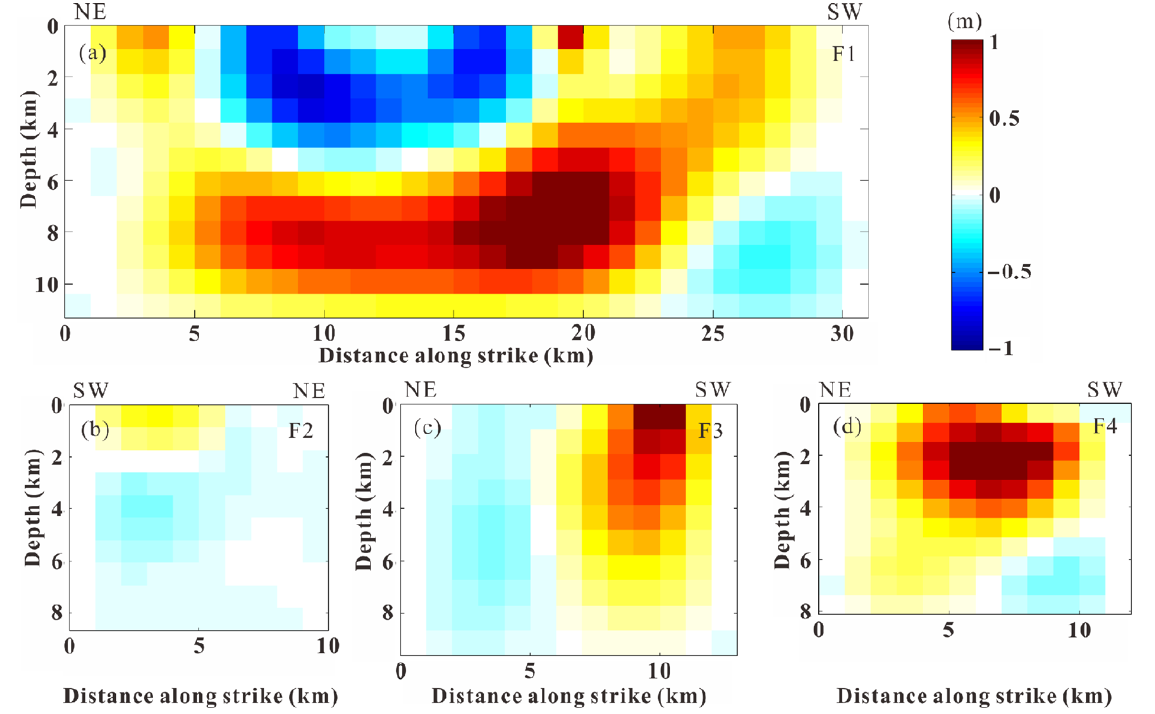
Figure 7. Comparison of the derived two slip models, respectively, solved by the AR–DR and DR–DL InSAR observations (slip in the AR–DR model minus slip in the DR–DL model). The subgraphs show the spatial distribution of the differences on the estimated faults.